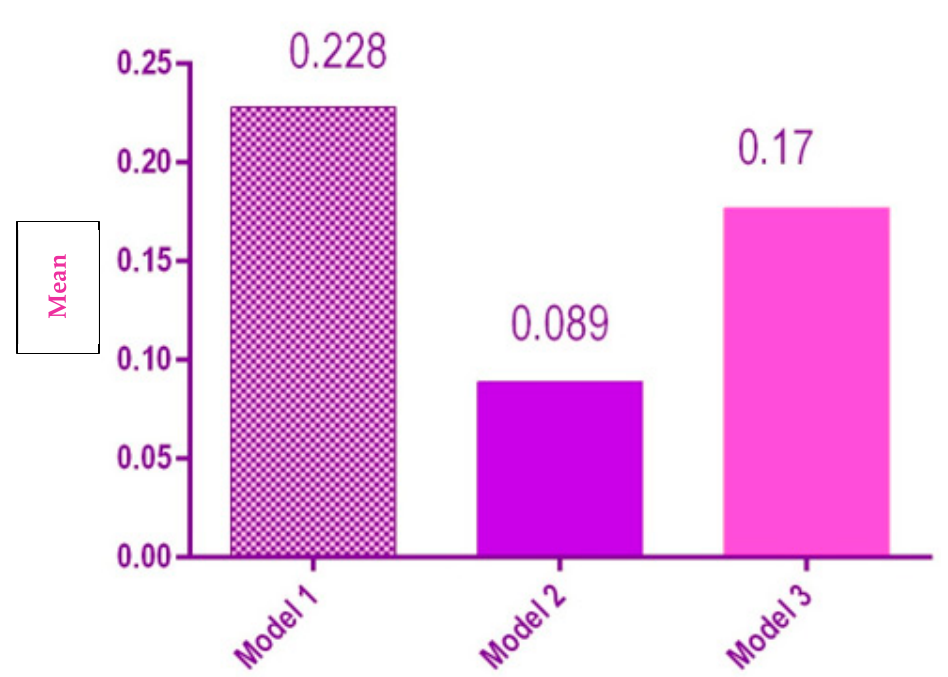
Figure 8. Statistical results of the length of the dental arch for the 3 models. Model 1 had a significantly larger vestibular-oral width than Model 2 and Model 3 ( p = 0.008) (Figure 9).